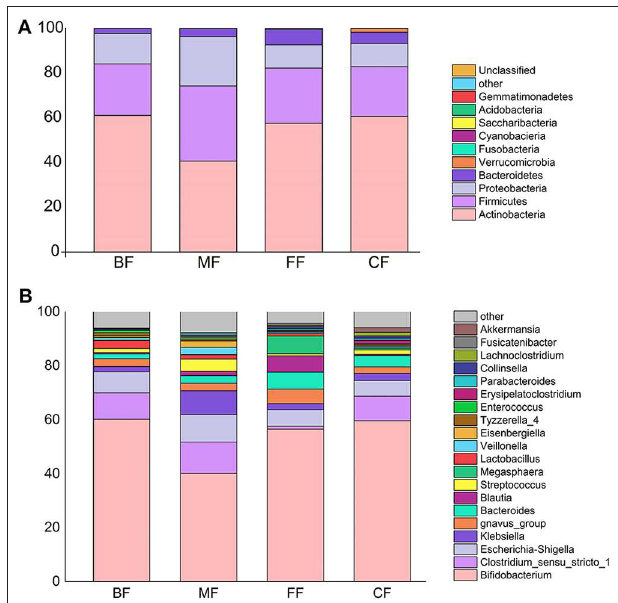
FIGURE 2 | (A) Comparison of community composition at the genera level. Only the top 10 most abundant genera are shown for demonstration and clarity. Each column represents a group. (B) Comparison of community composition at the phyla level. Only the top 10 most abundant phyla are shown for demonstration and